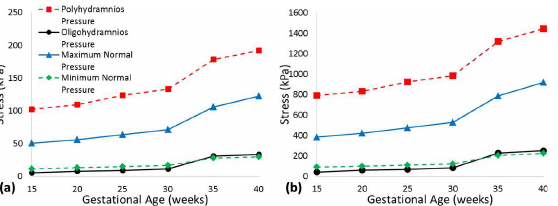
Fig 4. Predicted maximum principalstresses in (a) the chorion and (b) the amnion under application of previously observedmaximum and minimum intrauterinepressures, and intrauterine pressures during polyhydramnios and oligohydramnios, over gestation.